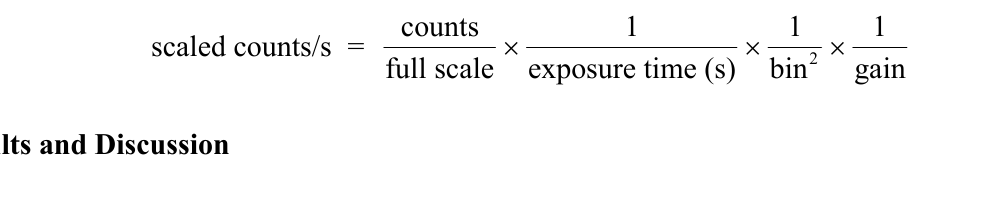
) and hydrodynamic radius (R g